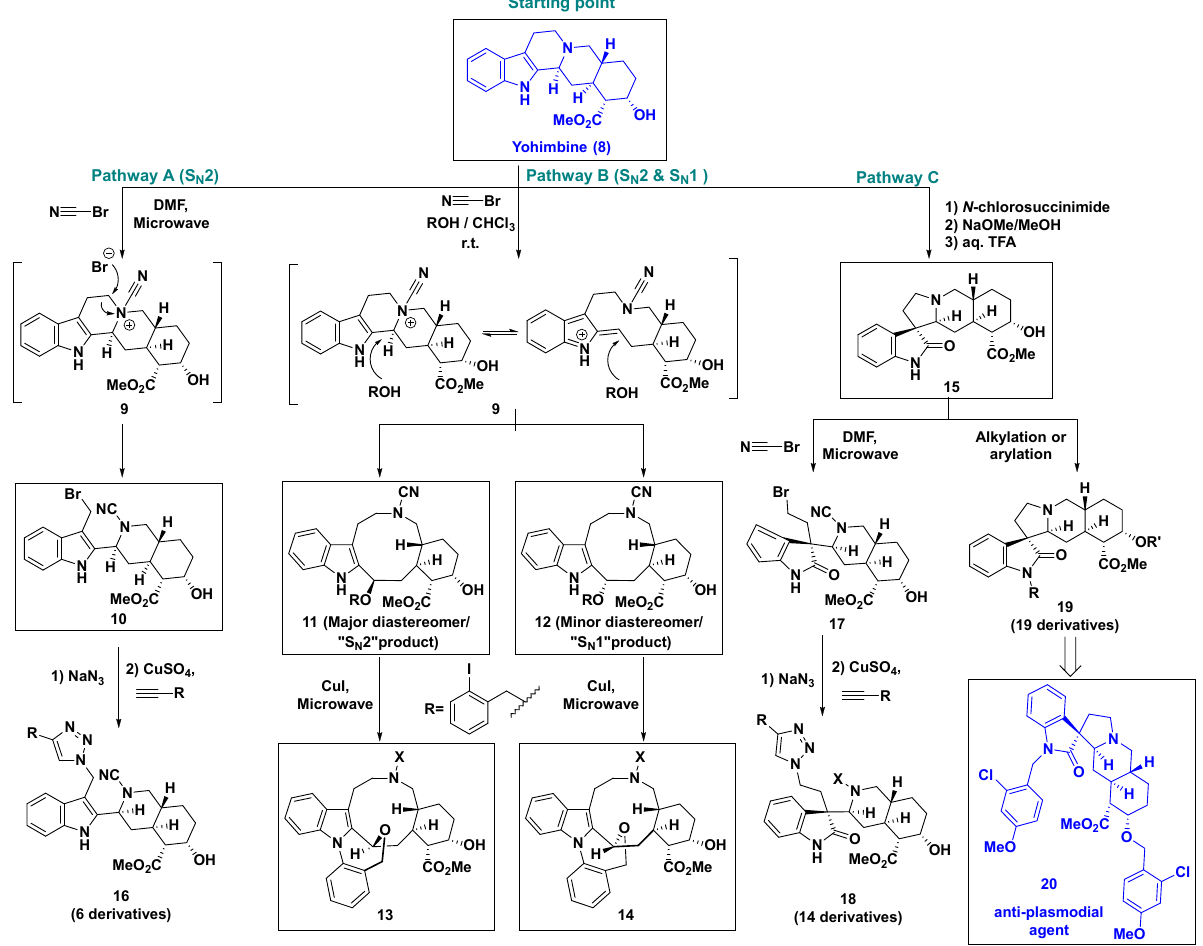
Scheme 1. Ring distortion of yohimbine ( 8 ) for rapid access to complex and diverse indole-based natural product-like small molecules and identification of new anti-plasmodial agent compound 20